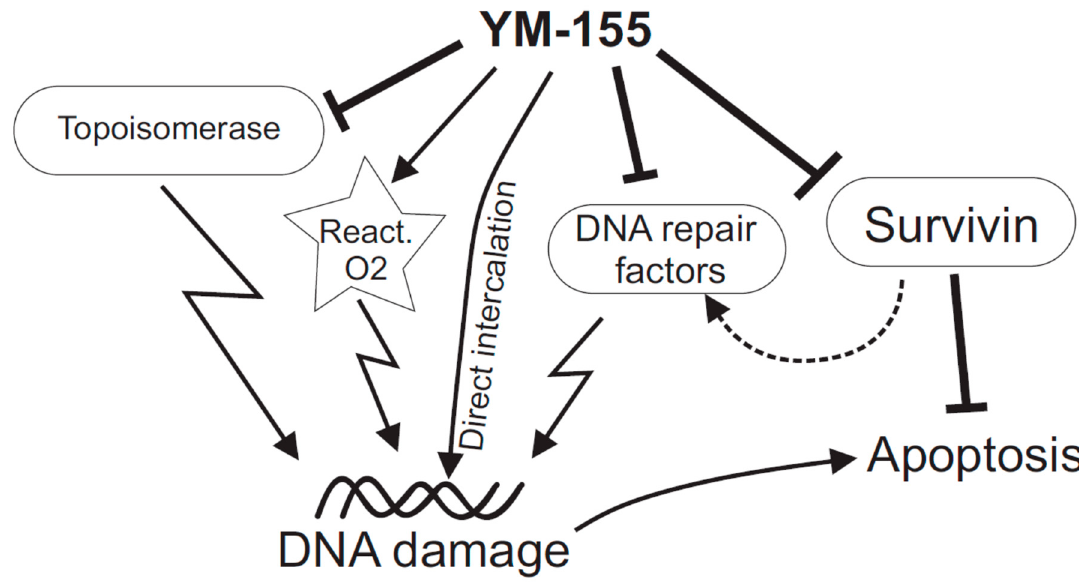
Figure 1. Scheme summarizing some of the suggested mechanisms of action of YM-155 on cancer cells. Apart from the primary target antiapoptotic factor, survivin, there is increasing evidence that YM-155 directly or indirectly damages DNA. The latter scenario may involve direct intercalation into DNA, inhibition of topoisomerases Top 2 α and Top-1, various alterations of DNA repair factors (which might also be Survivin-mediated), and emission of reactive oxygen species.